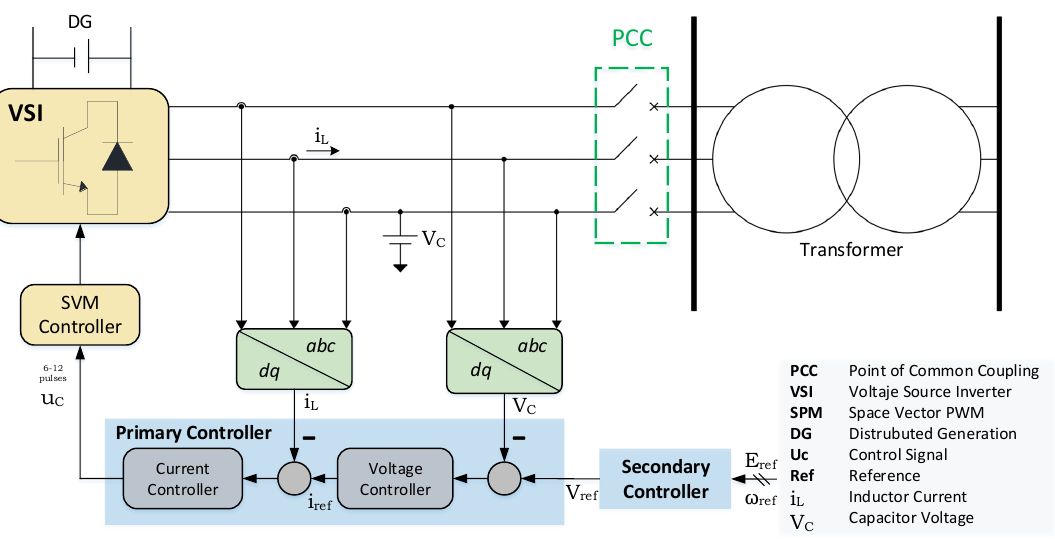
Figure 10. Secondary controller in